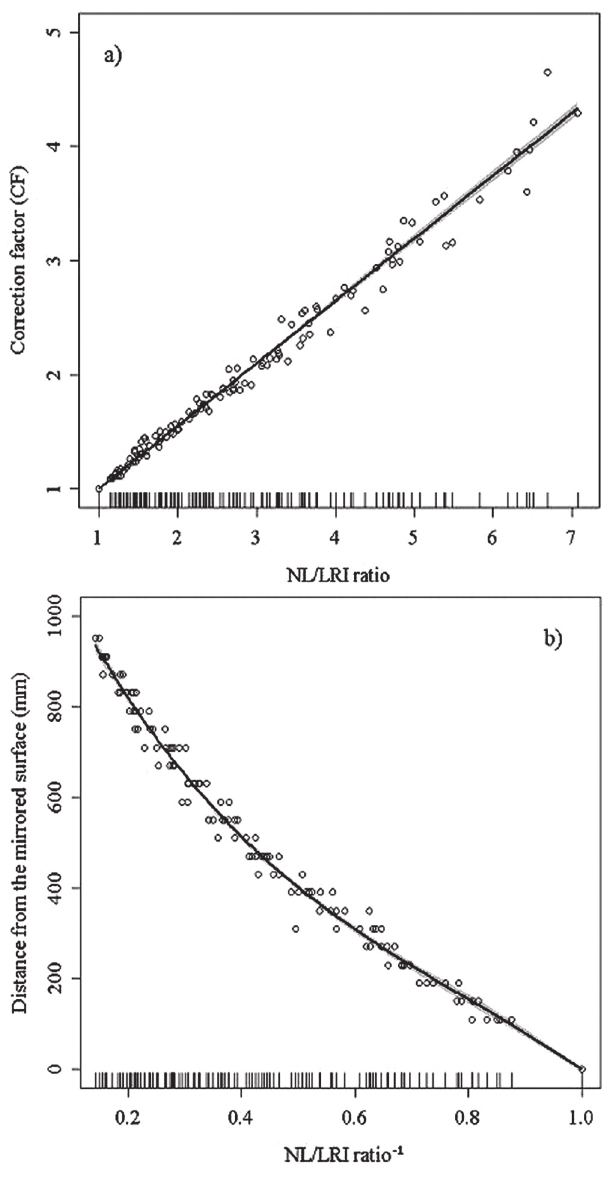
Fig. 2. Calibration (a) and ‘Height’ (b) functions for the Mirrored baited underwater video system (MBUV) system. The solid lines represent the fitted models. Shaded areas represent 95% confidence regions. Jittered rugs on the x-axis indicate the distribution of the NL/LRI ratio and NL/LRI ratio -1 data, respectively. NL = naive length, LRI = length of the reflected